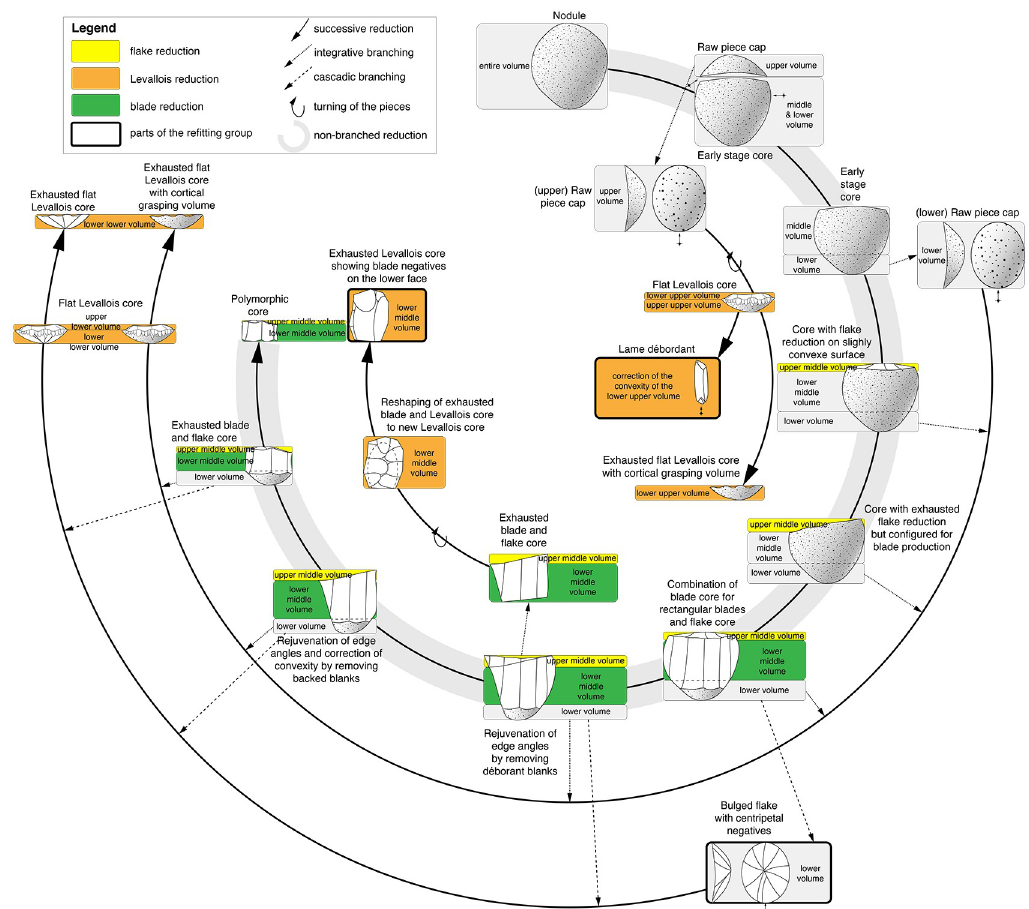
Fig 9. Schematic diagram of the reconstructed reduction sequence. Legend: The diagram contains all possible paths that can be followed with the reconstructed superordinate system. In addition to the non-branched reduction possibility, it contains the paths that can be taken through integrative and cascadic branching. The parts of the main refitting group are highlighted.